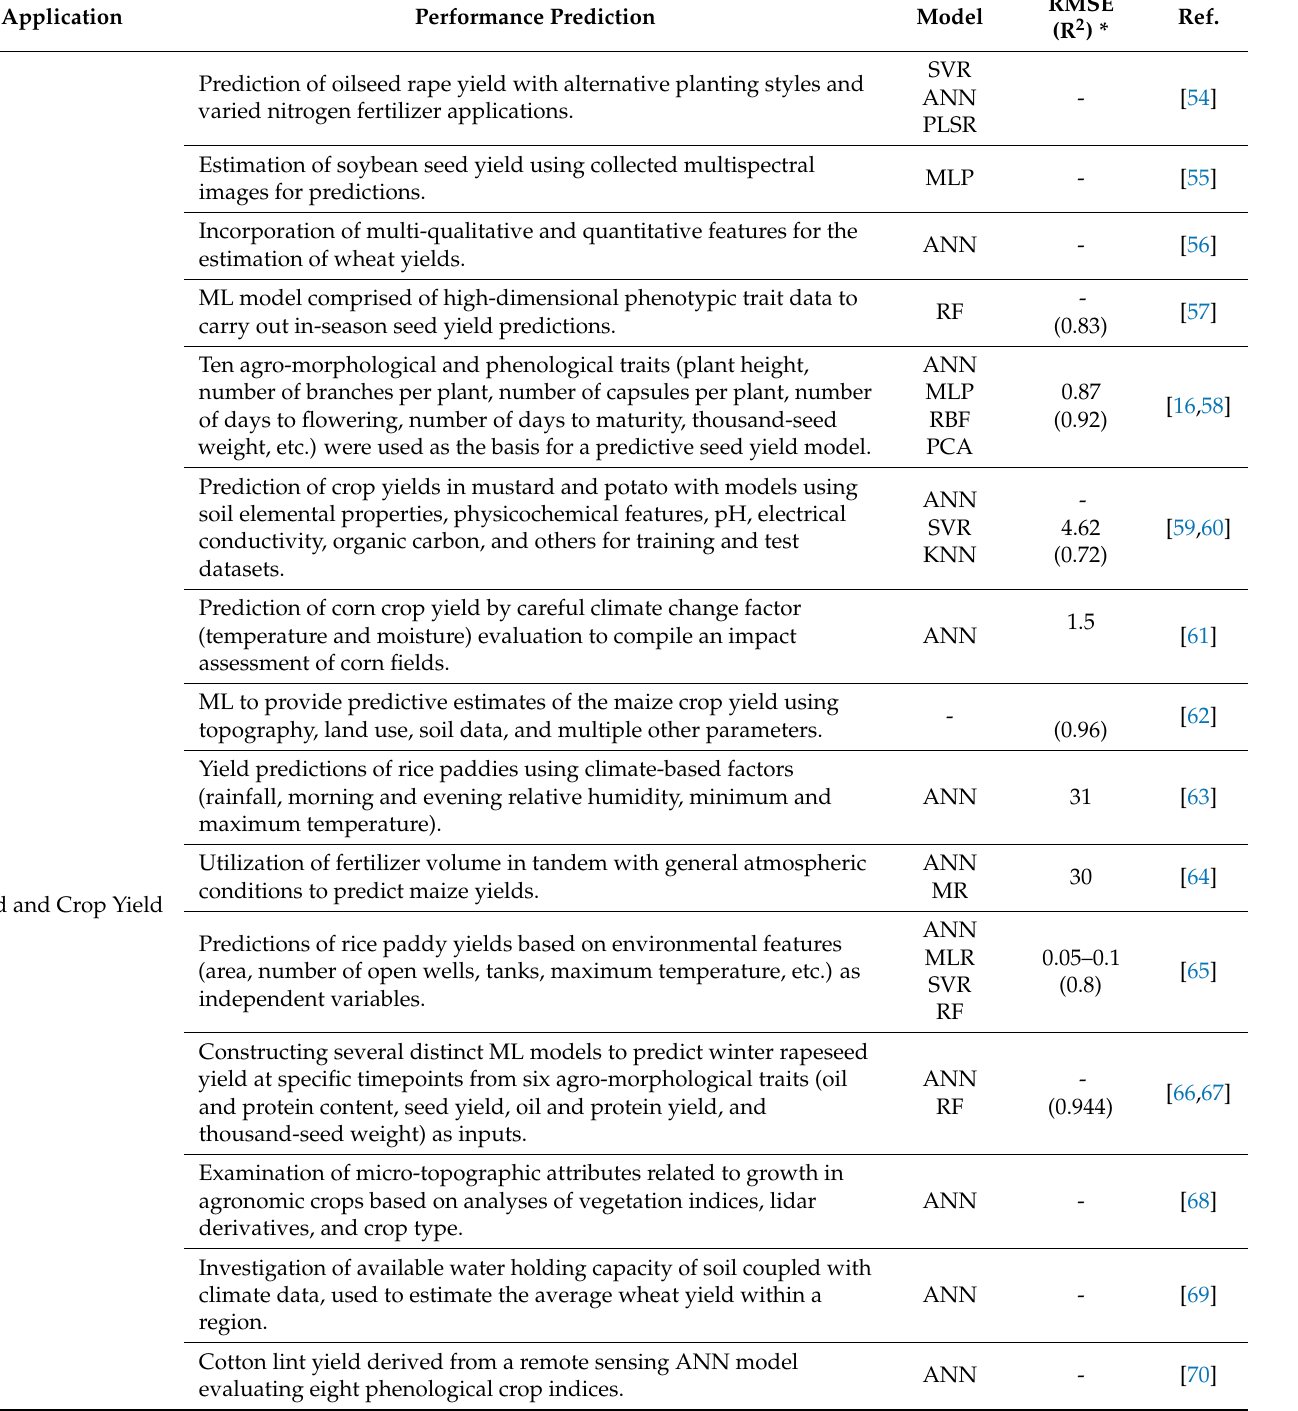
Table 1. A selection of previous studies using ML to advance agricultural crop research. Application Performance Prediction